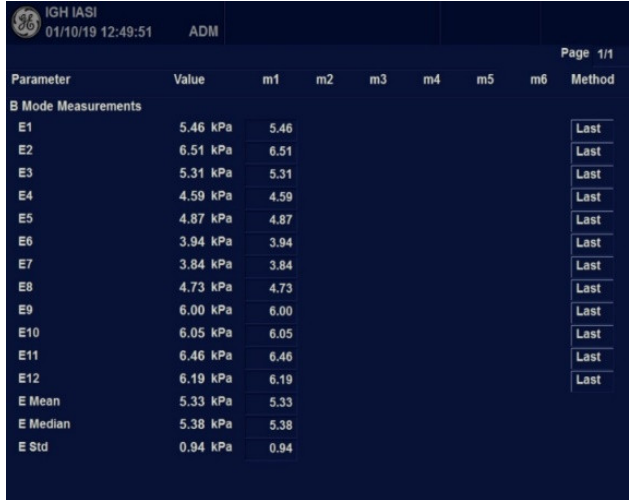
Figure 2. Worksheet with measurements results using 2D-SWE.GE. The ultrasound parameters assessed were: craniocaudal diameter of both, right lobe and left lobe of the liver (RLD and LLD), portal vein caliber (PV), and bipolar splenic di- ameter (BSD). The grade of steatosis was determined using a 4-grade classification system steatosis) [11].